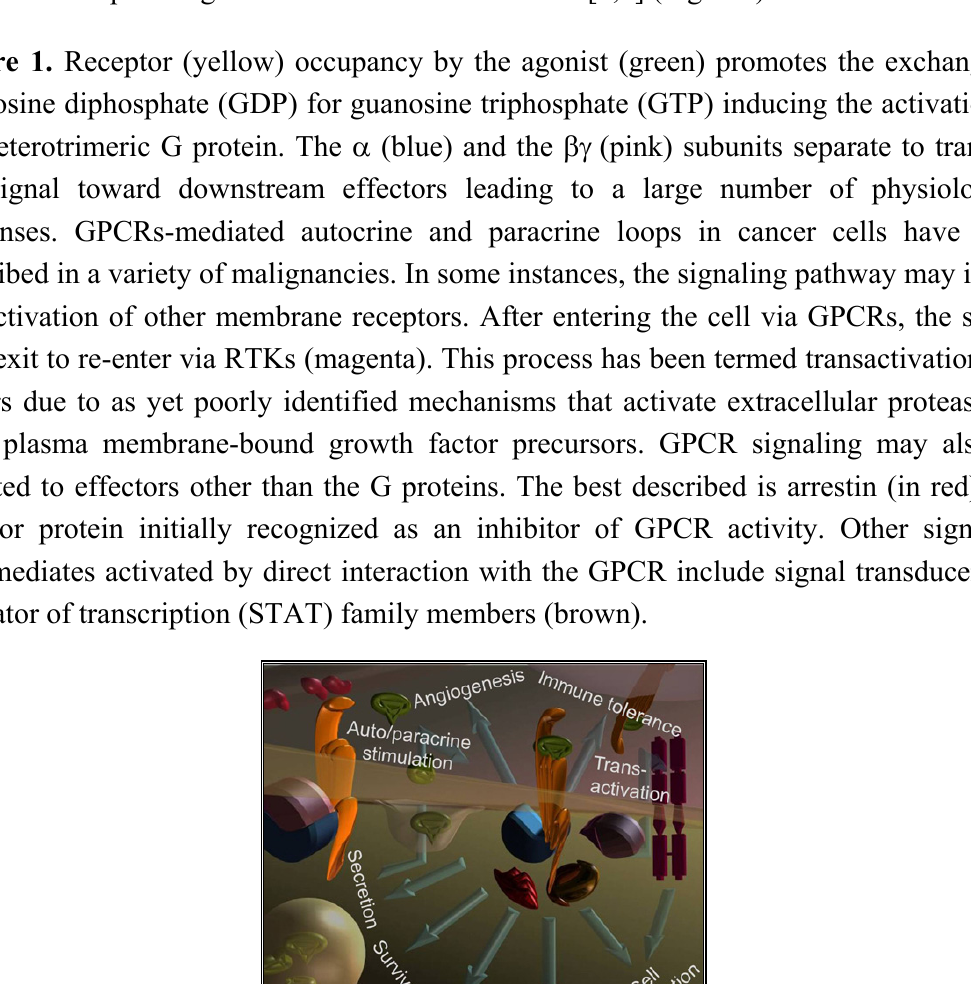
Figure 1. Receptor (yellow) occupancy by the agonist (green) promotes the exchange of guanosine diphosphate (GDP) for guanosine triphosphate (GTP) inducing the activation